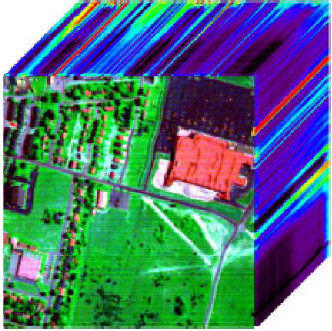
Figure 9. Real-world urban data.